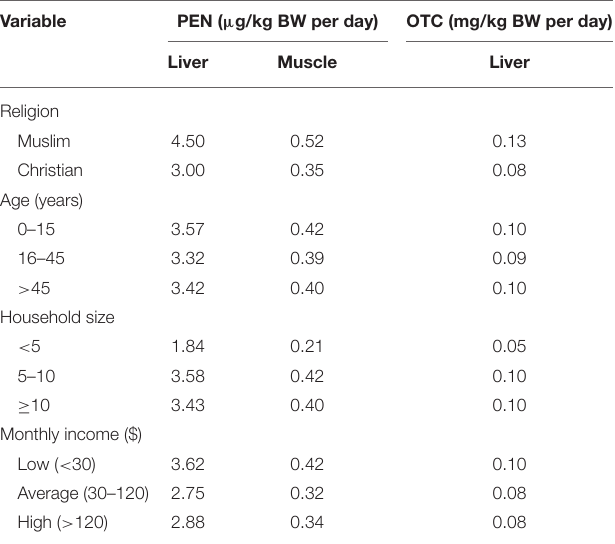
TABLE 4 | Global estimated acute dietary exposure assessments associated with the antibiotic residue intake in beef.